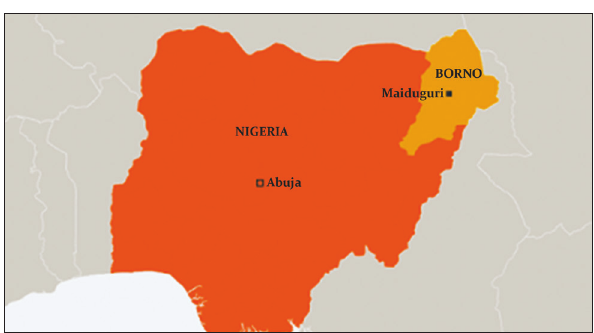
Figure-1: Map of Nigeria showing Maiduguri metropolitan in Borno State (study